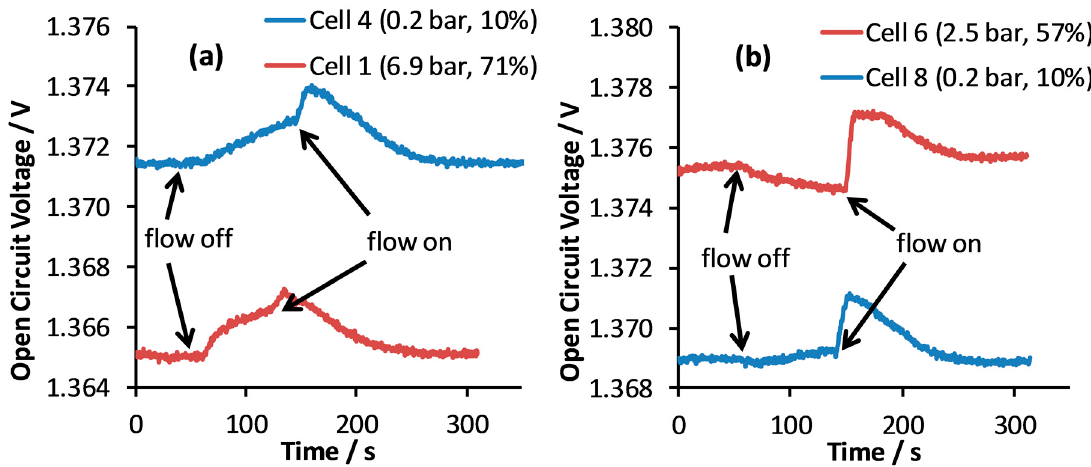
Figure 6. Plots of open circuit voltage vs. time for ( a ) Cells 1 and 4 (Nafion 117 membranes) and ( b ) Cells 6 and 8 (Nafion 212 membranes). Compression pressures and % compression values are given in brackets for each cell. Initially the flow rate was 100 mL min − 1 . Arrows indicate when the flow was turned off and then reactivated.